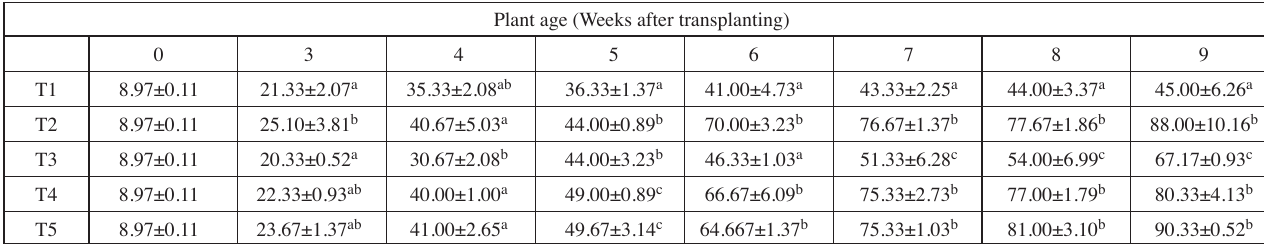
Plant age (Weeks after